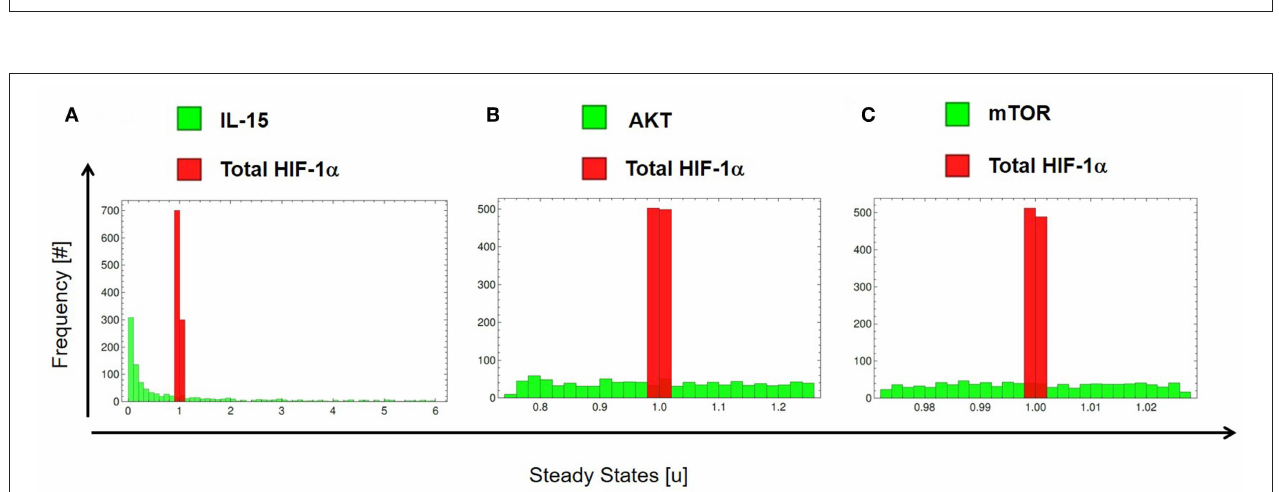
FIGURE 10 | Stochastic extrinsic and intrinsic perturbations of the HIF-1 α regulatory network in IL-15 stimulated cells treated with DMOG. Histograms accounting for total HIF-1 α relative steady state variations after stochastically varying (A) IL-15, (B) the AKT basal activation rate ( a 2 ), and (C) the mTOR basal activation rate ( a 3 ). The model is robust to internal and external stochastic perturbations, indicating that variation of ± 25% in the above elements result in minimal variations ( < 10 % ) in the steady state of total HIF-1 α .